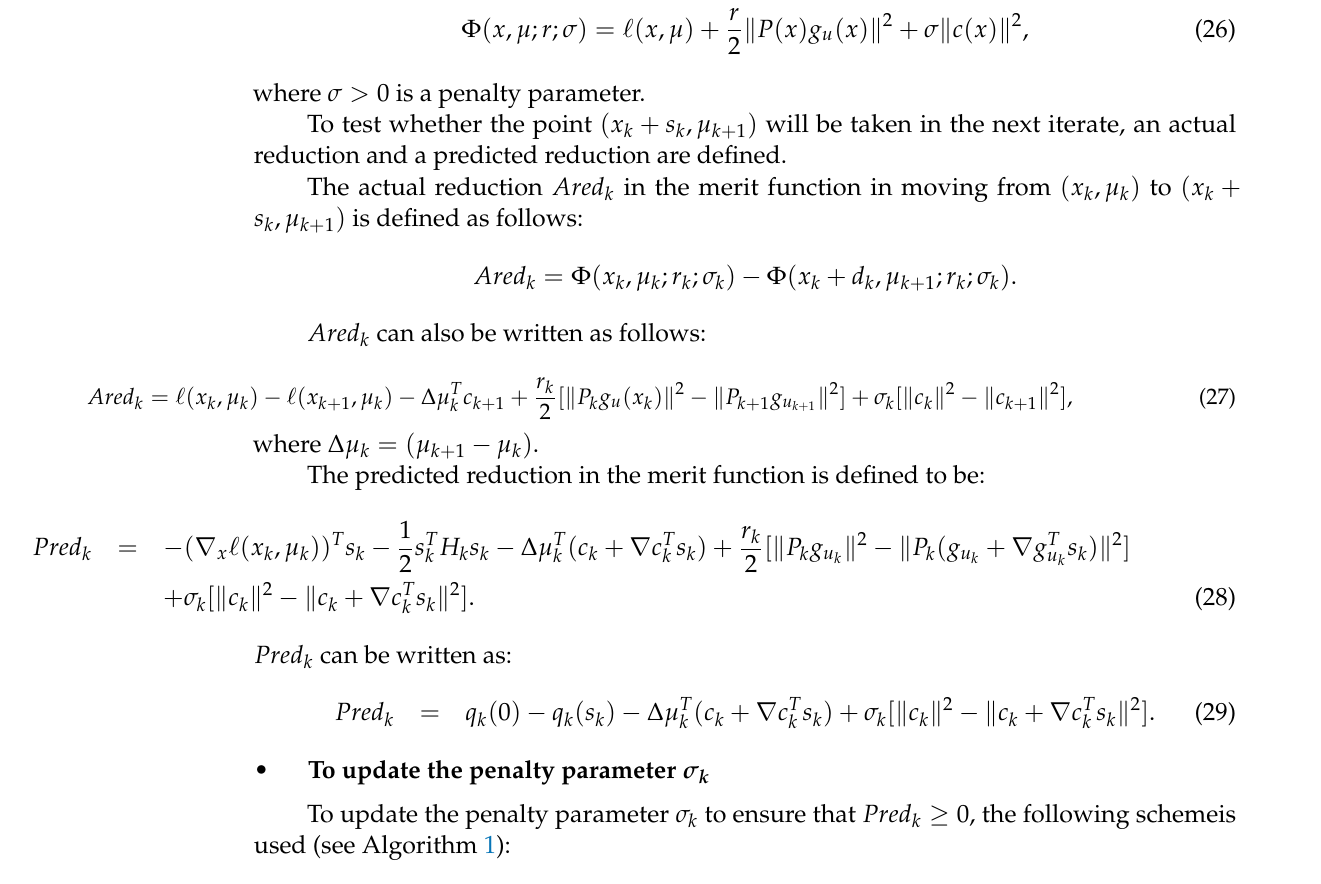
Algorithm 1 To update the penalty parameter σ